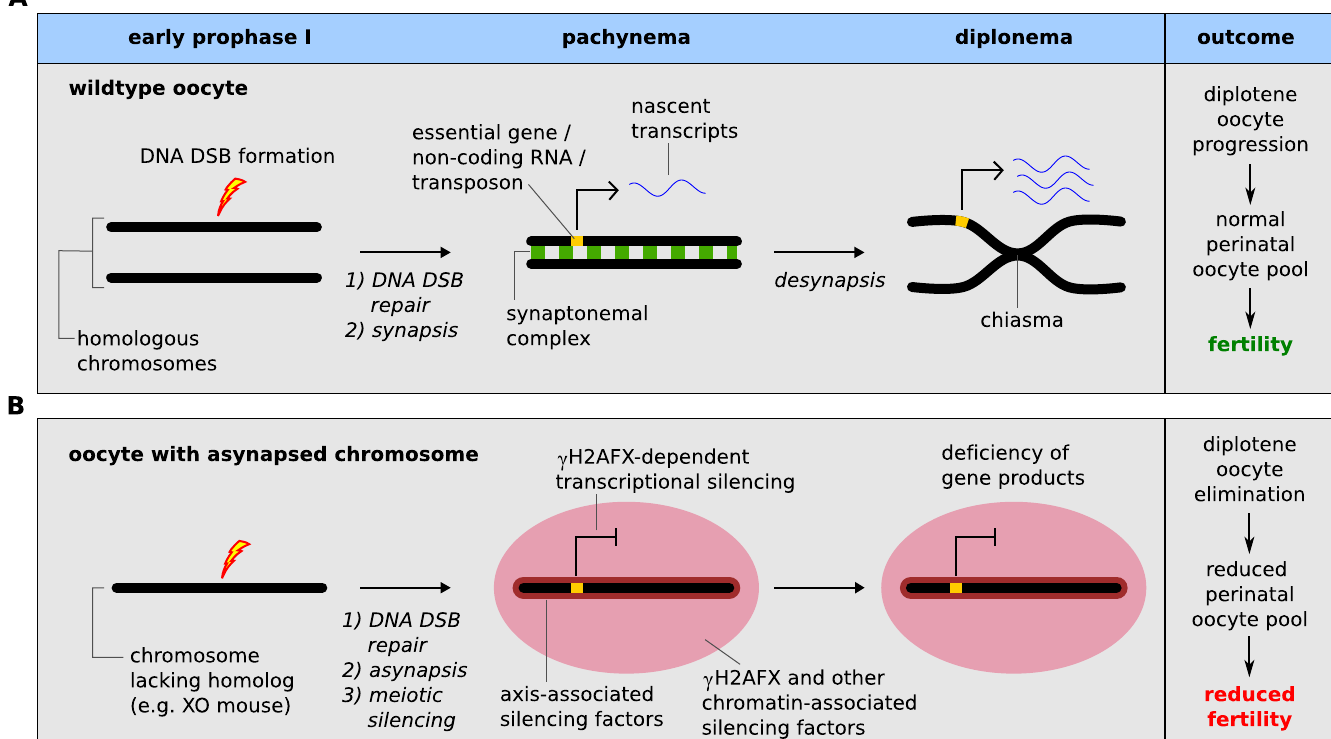
Fig 5. Meiotic silencing model of prophase I oocyte elimination. ( A ) Wild type oocyte: Meiotic DNA DSBs are formed during early prophase I by SPO11 (lightning bolt). During pachynema, homologous chromosomes synapse and meiotic DSB are repaired (DSB repair proteins shown as a red star). At diplonema, homologs desynapse and remain connected at crossover sites (chiasma). Essential genes (yellow block on chromosome) are actively transcribed during pachynema and diplonema (transcripts shown as blue ribbon). ( B ) Oocytes with a chromosome abnormality that disrupts meiotic pairing (i.e. XO oocyte): As in wild type oocytes, meiotic DNA DSBs are formed in early prophase I and are repaired on the asynapsed chromosome during pachynema. At pachynema, however, the chromosome lacks a homolog and remains asynapsed, triggering meiotic silencing, which is mediated both by axial-associated and chromatin-associated silencing factors, such as γ H2AFX (red domain). This results in silencing of essential genes on the asynapsed chromosome. This consequence of essential gene silencing is oocyte elimination during diplonema and subsequent reduced fertility.